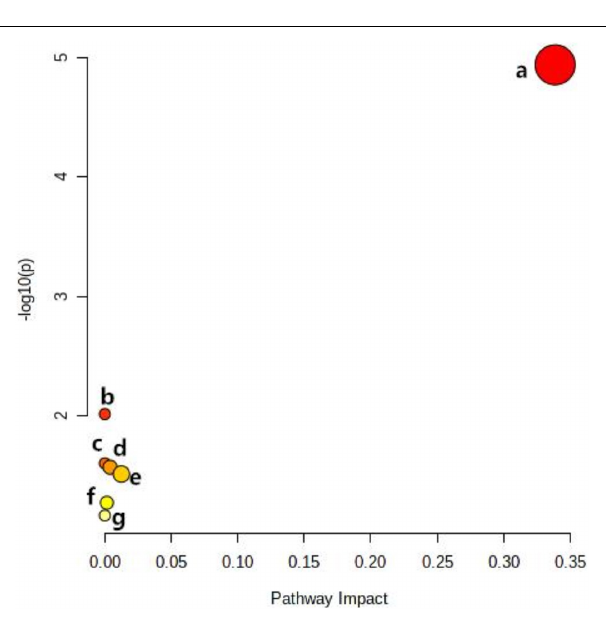
FIGURE 5 | Ingenuity pathway analysis based on the 13 lipid metabolites with higher diagnostic performance. The p -value (y-axis) was represented by the color of the circle and the pathway impact (x-axis) was indicated by the size of the circle. Glycerophospholipid metabolism (a), Linoleic acid (b), alpha-Linolenic acid metabolism (c), Glycosylphosphatidylinositol (GPI) (d), Glycerolipid metabolism (e), Phosphatidylinositol signaling system (f), and Arachidonic acid metabolism